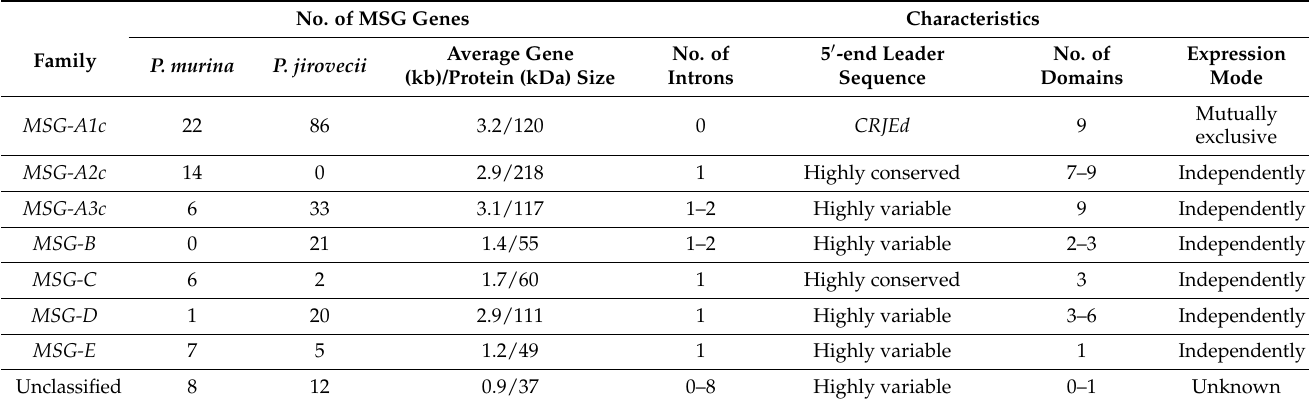
Table 6. Summary of the MSG superfamily members identified in Pneumocystis